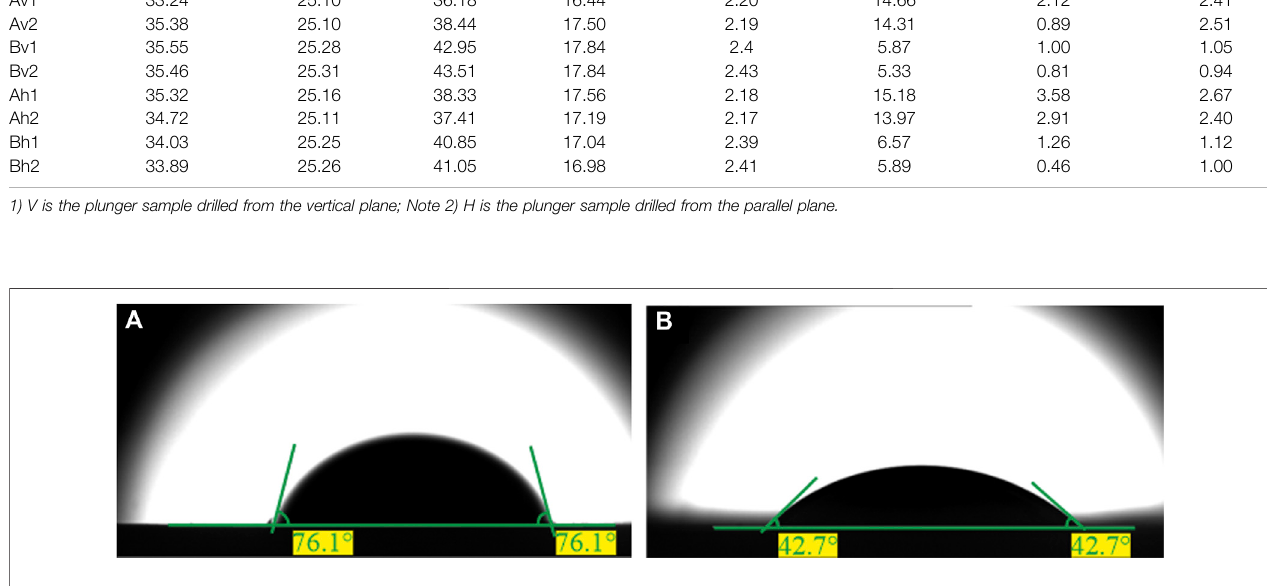
FIGURE 5 | Results of wettability test of cores (A) and (B)